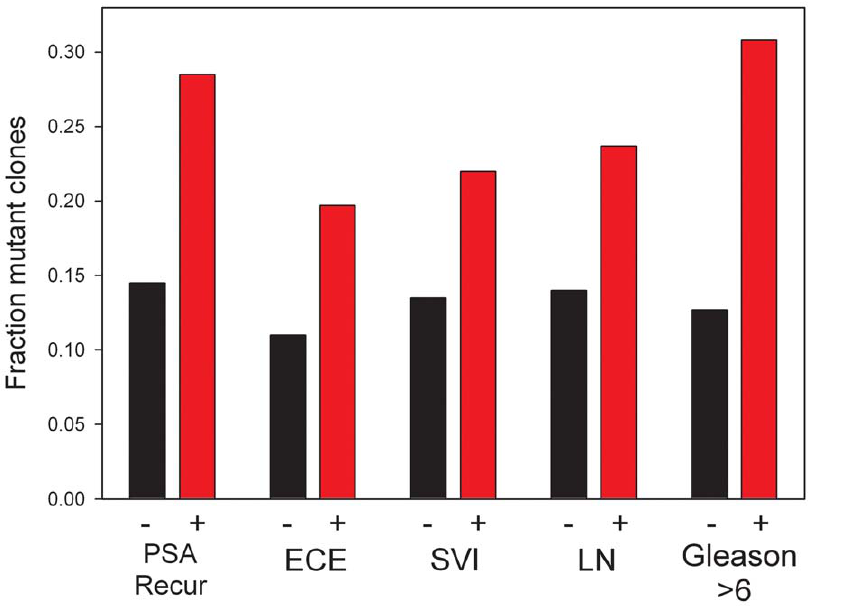
Figure 2. Association of GAP domain mutations with clinical and pathological parameters associated with aggressive prostate cancer. The fraction of clones containing missense or stop mutations for cases with each indicated clinical or pathological parameter is shown. All differences between pathological and clinical variables were statistically significant. Specifically: for early PSA recurrence ( , 2 years post surgery) versus no or late recurrence (p , 0.001, chi sq); extracapsular extension (ECE) versus no ECE (p=0.015, chi sq); seminal vesicle invasion (SVI) versus no SVI (p=0.027, chi sq); pelvic lymph node metastasis (LN) versus no metastasis (p=0.027, chi sq); Gleason 5/6 versus 7–10 (p=0.002, chi sq).